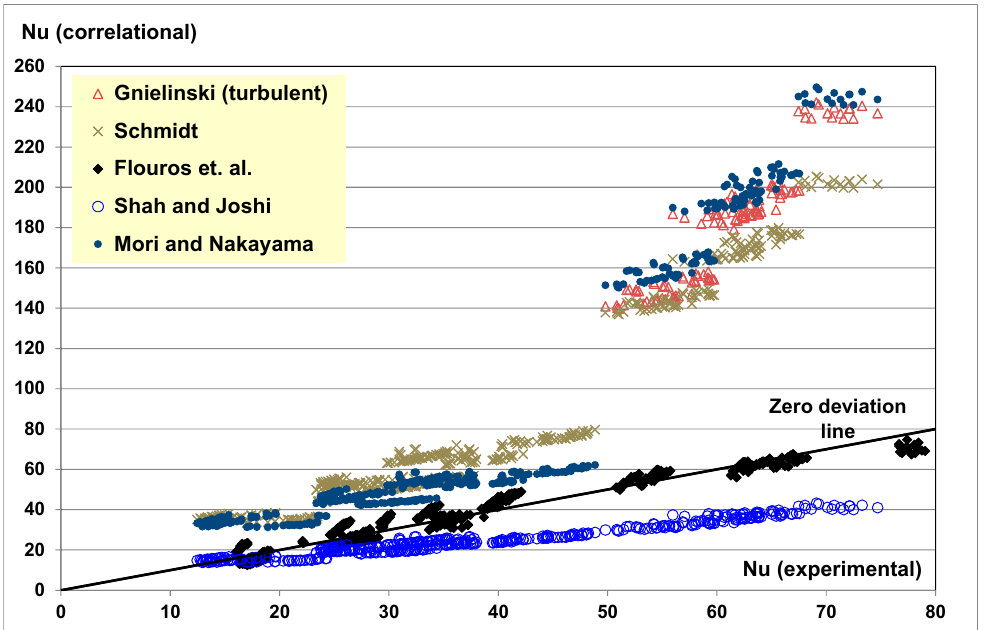
Figure 11. Comparison of Nusselt number correlations to the test results (first set).